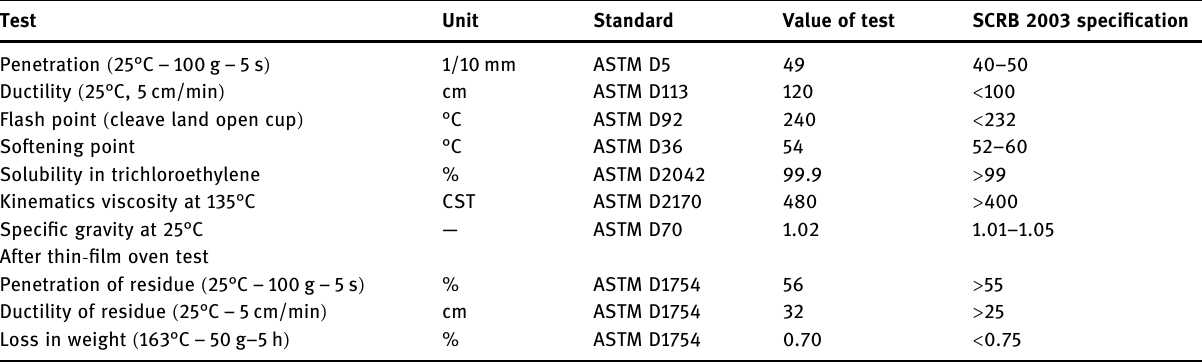
Table 1: Asphalt cement ’ s physical characteristics [ 15 ]